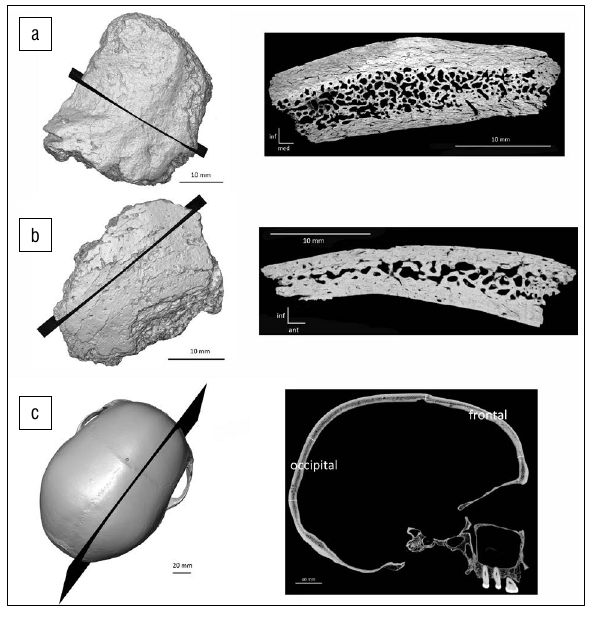
figure 2: Cranial structural organisation along sections extracted from (a) StW 671 and (b) StW 672. Comparative measurements come from (c) the frontal and occipital parts of the parasagittal section extracted from the comparative sample. White lines in (c) delimitate the frontal and occipital portions of the cranial vault.